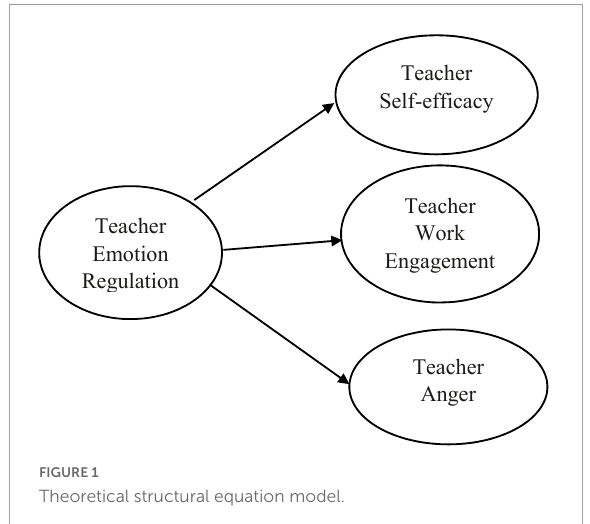
FIGURE1 Theoretical structural equation